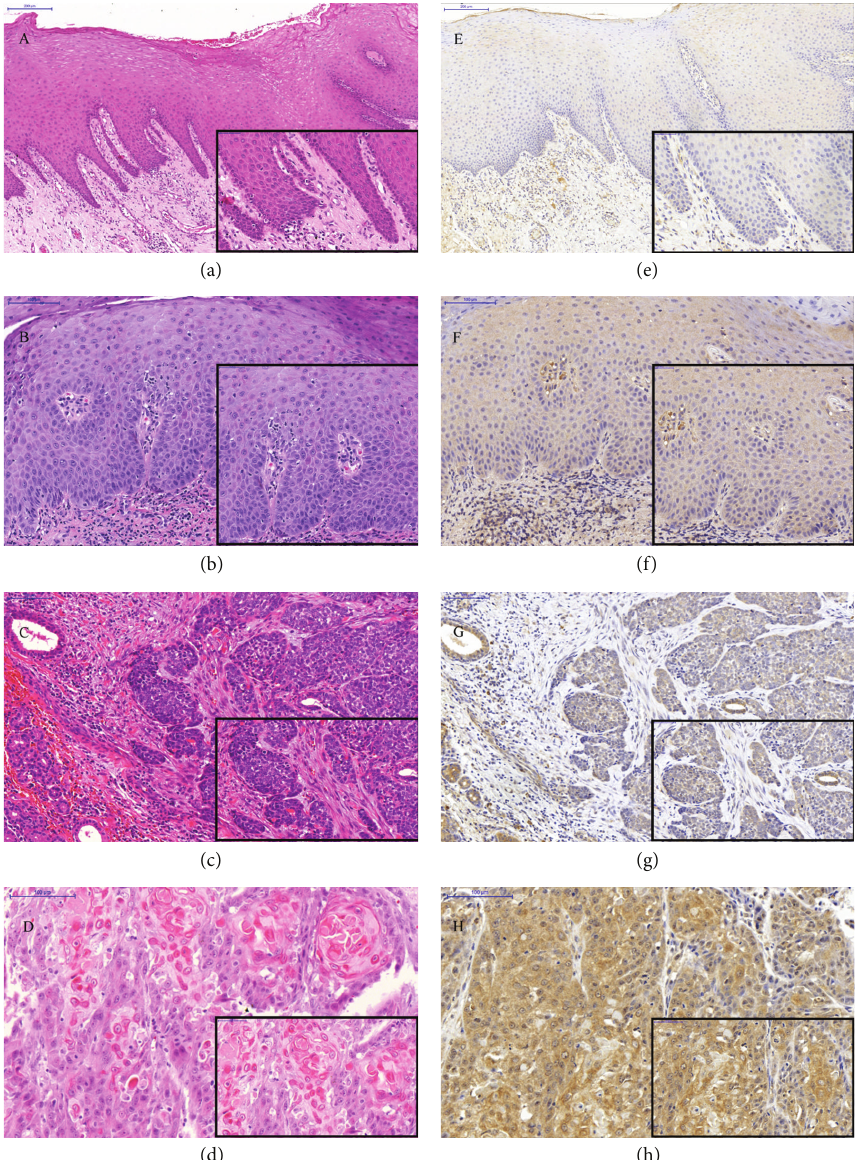
Figure 4: Immunohistochemistry of MMP13 . Normal oral mucosa (a) H&E stain (magnification 400x and 1600x); (e) anti- MMP13 antibody immunostain was negative in the normal oral mucosa (magnification 400x and 1600x). Dysplastic oral tissue (b) H&E stain (magnification 800x and 1600x); (f) anti- MMP13 antibody showed weak to moderate immunostaining in the cytoplasm of the dysplastic epithelial cells (magnification 800x and 1600x). OSCC (c and d) H&E stained (magnification 800x and 1600x); (g) anti- MMP13 antibody immunostaining showed low expression and (h) high expression in the cytoplasm of the epithelial tumor cells (magnification 800x and 1600x). All the oral tissues showed moderate anti- MMP13 antibody immunostaining of the stroma and inflammatory cells in the microenvironment.